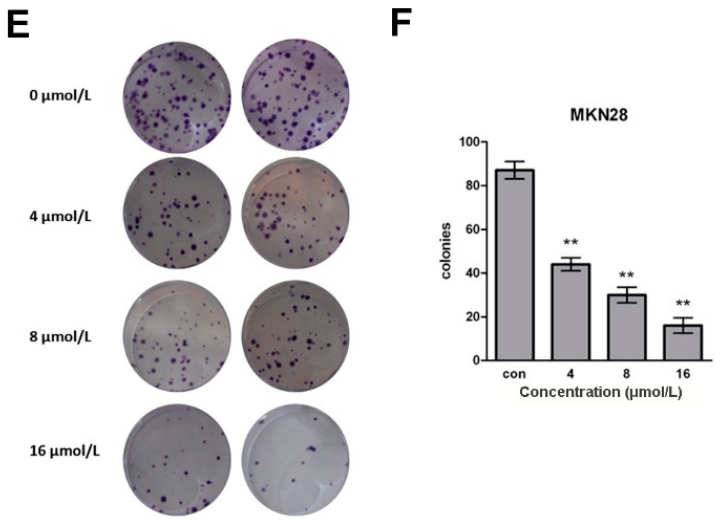
Figure 1. CVB-D induces cell viability of MGC-803 and MKN28 cells. ( A , B ) MTT assays of cell viability of MGC-803 ( A ); and MKN28 cells ( B ) at 24, 48 and 72 h after treatment with CVB-D (0, 30, 60, 120 and 240 µmol/L). Each experiment involved at least three replicates; ( C , E ) Representative images of crystals violet staining assays of CVB-D (0, 4, 8 and 16 µmol/L) treated MGC-803 ( C ); and MKN28 cells ( E ); ( D , F ) Colony numbers of CVB-D treated MGC-803 ( D ); and MKN28 cells ( F ). ** p < 0.01. Each experiment involved at least three replicates.